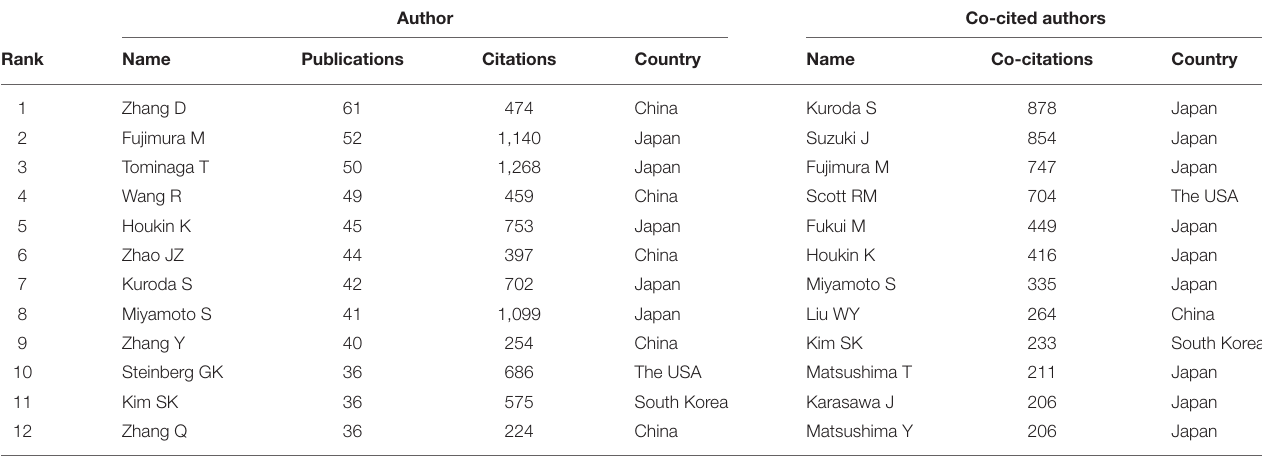
TABLE 4 | The top 12 prolific authors and co-cited authors on MMA research from 2010 to